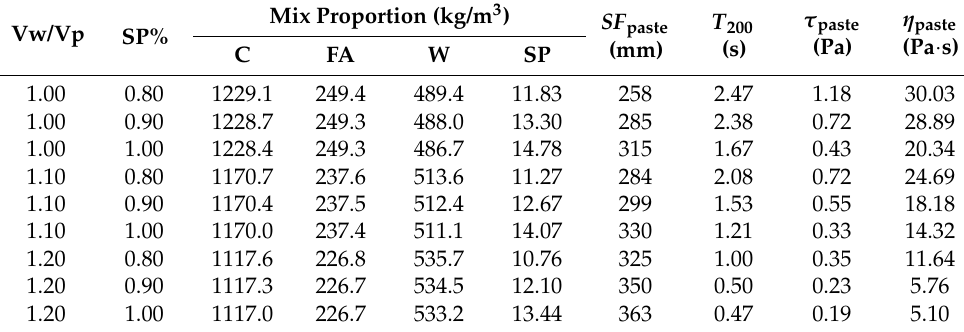
Table 6. Mix proportions and test results of paste in series 2.